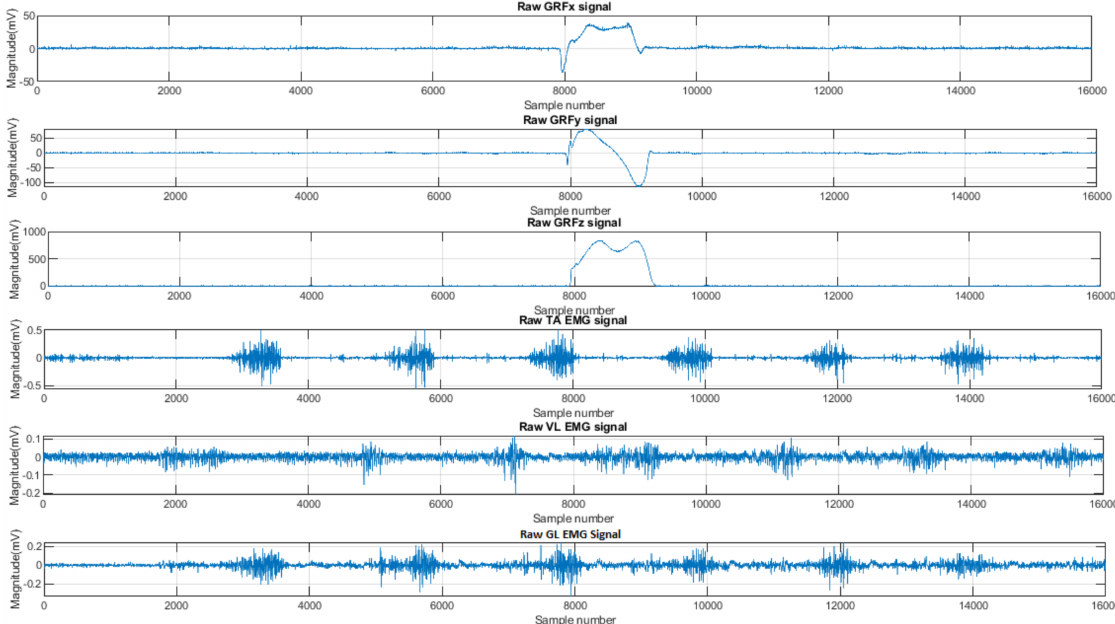
Figure 1. Sample of raw EMG signals from three lower limb muscles and 3-dimensional GRF signals Re-printed with permission from ref. [5]. Copyright Year 2022, Isabel C.N. Sacco, (Physical Therapy, Speech, and Occupational Therapy Department, School of